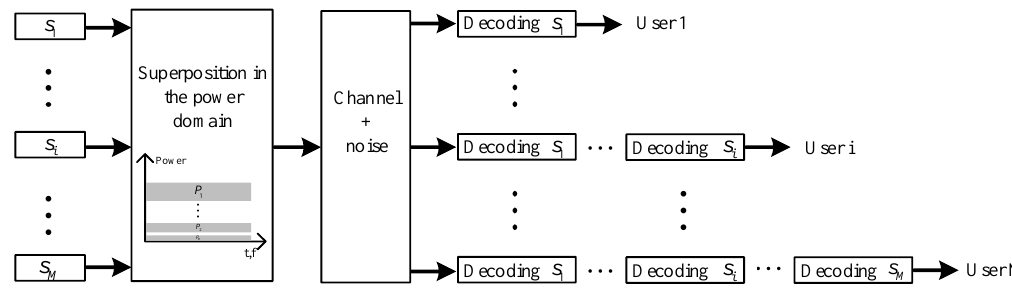
Figure 1. Illustration of the conventional NOMA